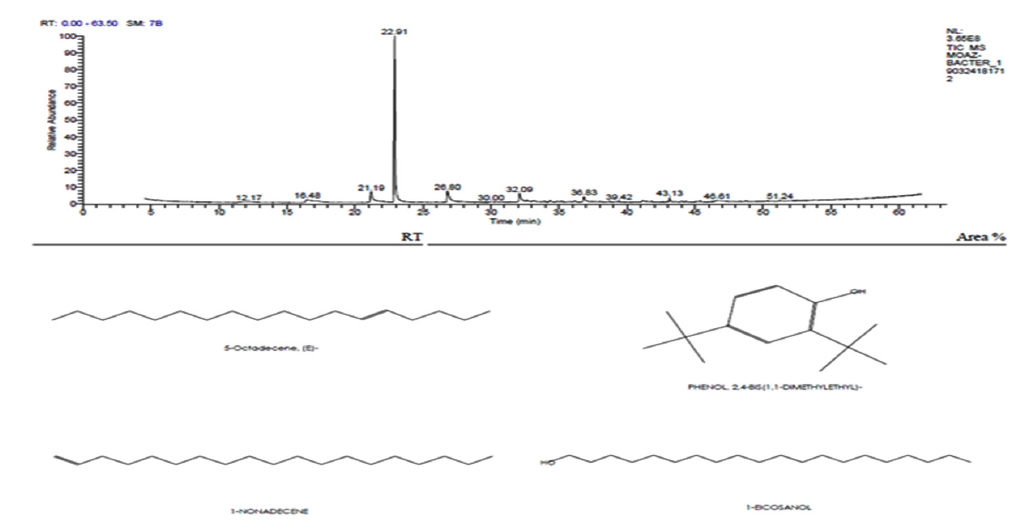
Fig. 6 . GC-MS chromatogram and structure formulas of compounds of the bioactive compounds extracted from Streptomyces sp. strain MK388207